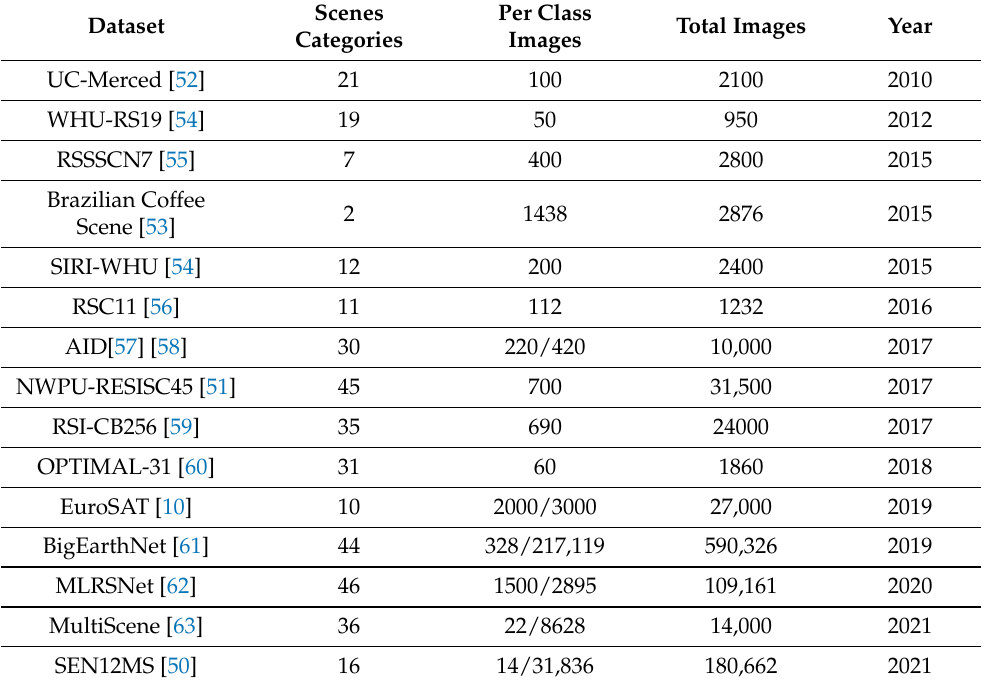
Table 2. Datasets for RS scene classification. When classes are unbalanced we specify minimum and maximum number of samples per